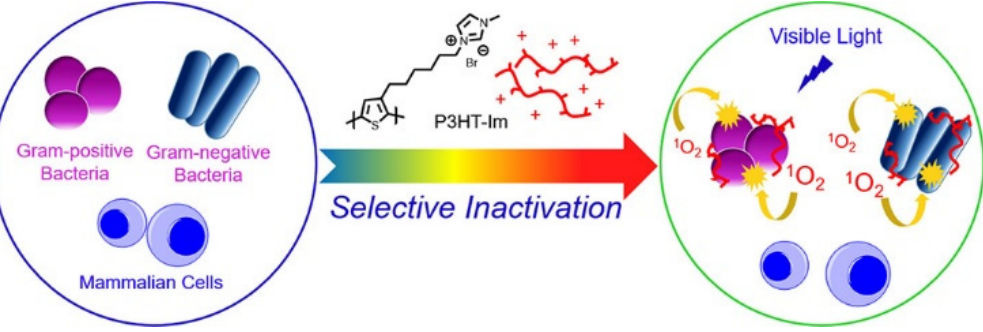
Figure 3. Schematic diagram of selective inactivation of bacteria over mammalian cells by P3HT-Im. Reprinted with permission from Ref. [30]. Copyright 2017 American Chemical Society.